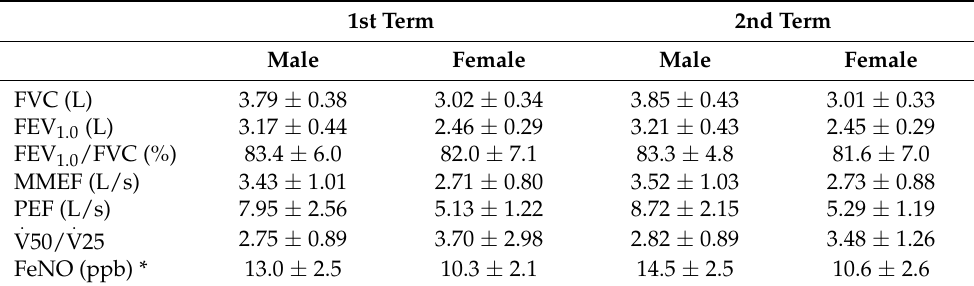
Table 4. Summary of pulmonary function and exhaled nitric oxide measurement (mean ±